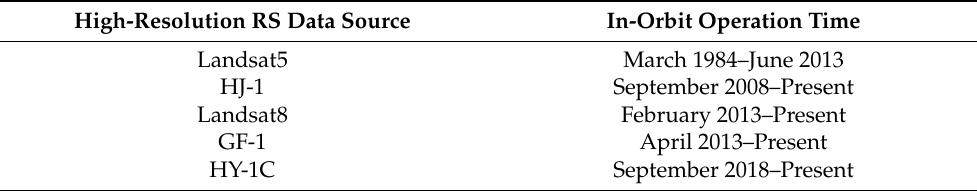
Table 9. In-orbit operation times of high-resolution RS